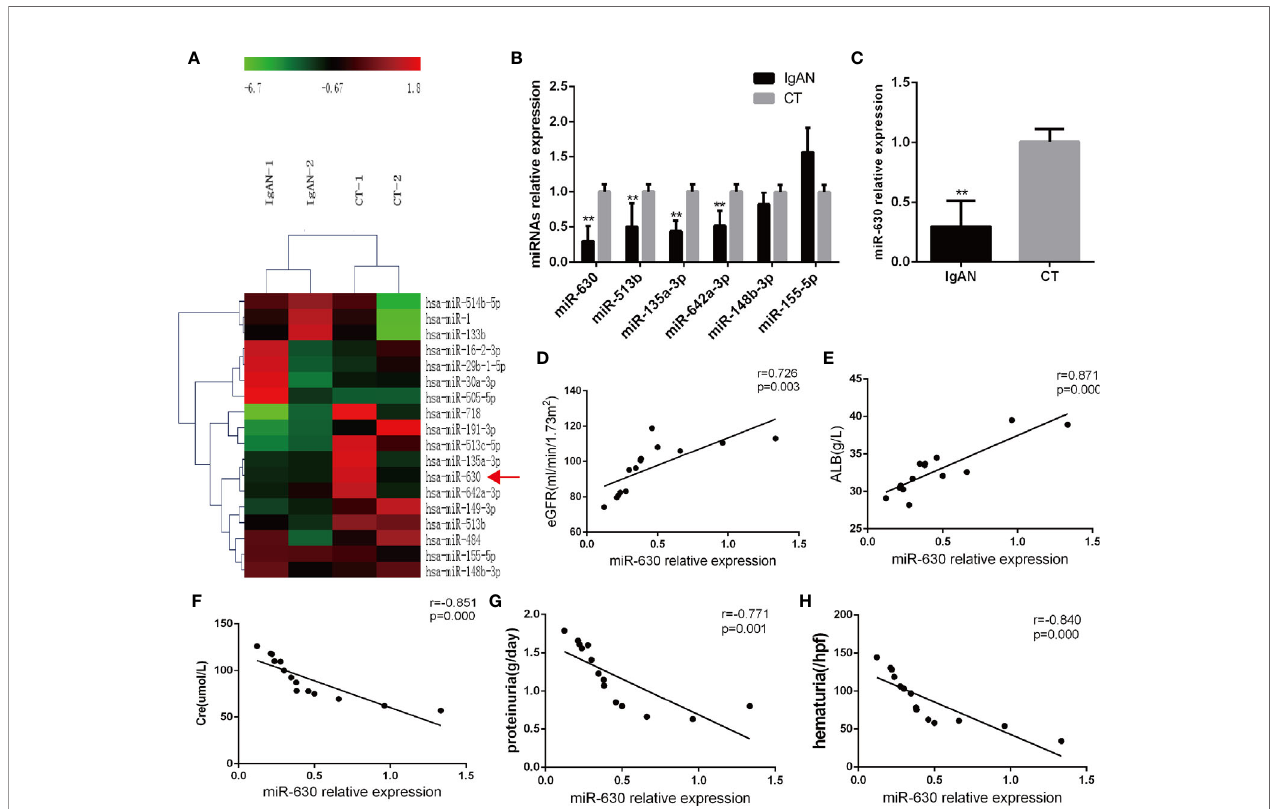
FIGURE 1 | miR-630 is decreased in the tonsil tissue of the IgAN group . (A) The microarray analysis detected the different expression of microRNAs (miRNAs) in palatine tonsil tissue between IgAN group and CT group. N=2. (B) Quantitative reverse transcription-PCR (qRT-PCR) con fi rmed the different expression of miRNAs between IgAN group and CT group. (C) The expression of miR-630 was detected in tonsil mononuclear cells (TMCs) derived from the IgAN group and CT group, respectively. (D – H) The correlation between the expression of miR-630 and the clinical parameters including estimated glomerular fi ltration rate (eGFR), albumin (ALB), Cre, proteinuria, and hematuria were analyzed by Pearson correlation analysis and linear regression analysis. N=14. The data were expressed as mean ± SEM, **p < 0.01. IgAN, IgA nephropathy, N=27; CT, chronic tonsillitis,